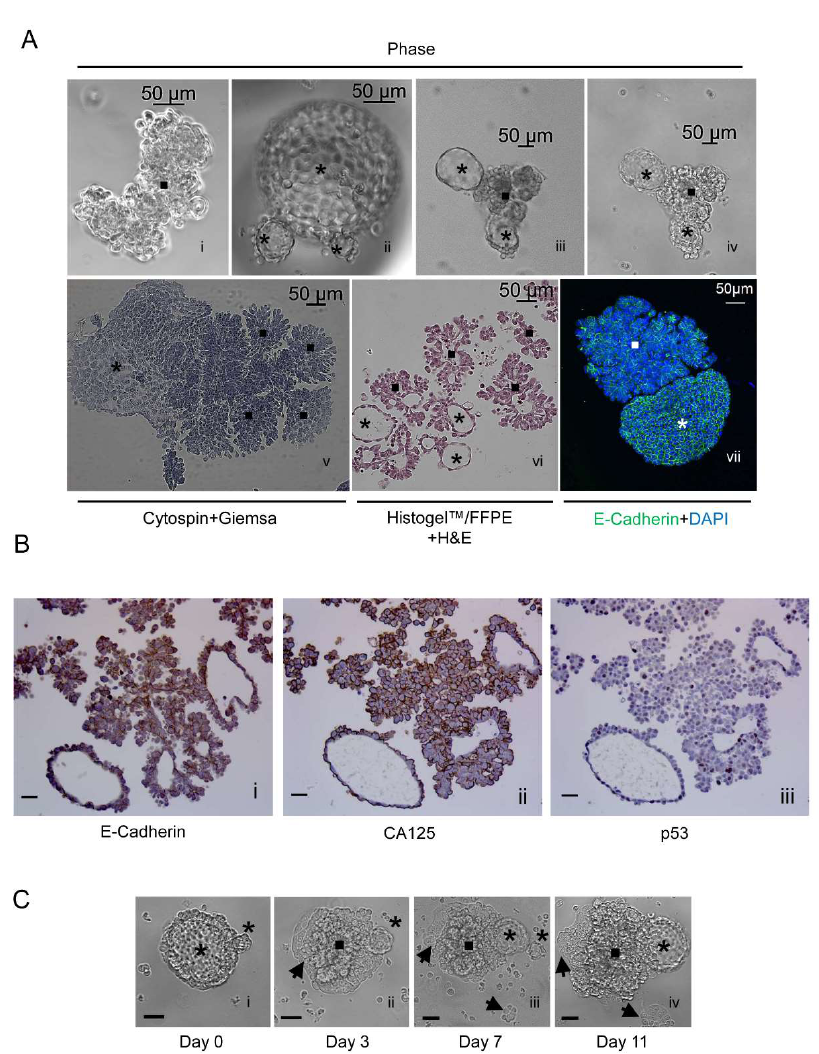
Figure 3. ( A ) [i–iv] Phase-contrast images of irregular and spheroidal PEO6 multicellular structures;